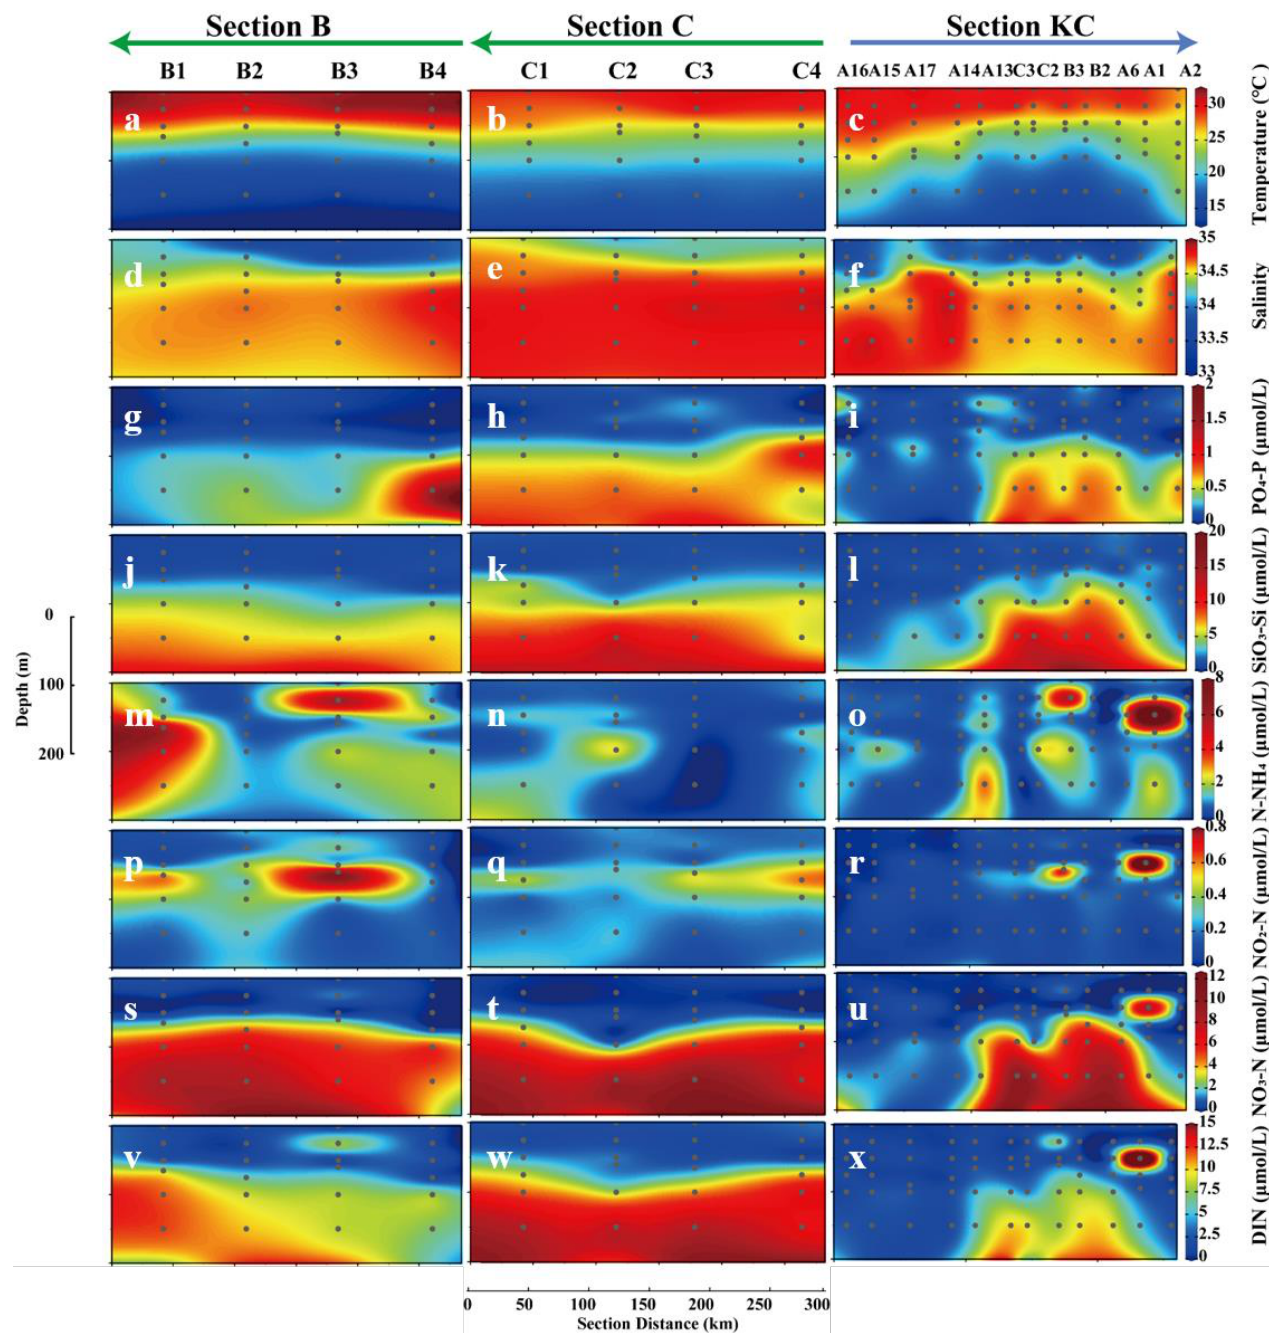
Figure 3. Vertical distribution of environmental variables (temperature ( a – c ), salinity ( d – f ), PO 4 -P ( g – i ), SiO 3 -Si ( j – l ), N-NH 4 ( m – o ), NO 2 -N ( p – r ), NO 3 -N ( s – u ), DIN ( v – x )) in section B, C, and KC. The green arrow represents the direction of the upwelling, and the blue arrow represents the direction of the Kuroshio current.